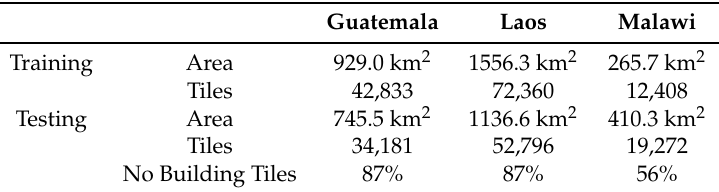
Table 1. Study Sites